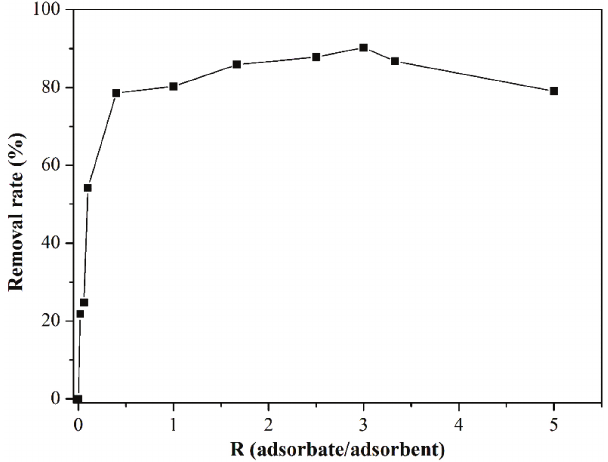
Fig. 6 – CA removal rate as a function of the mass ratio (CA/CLDH)